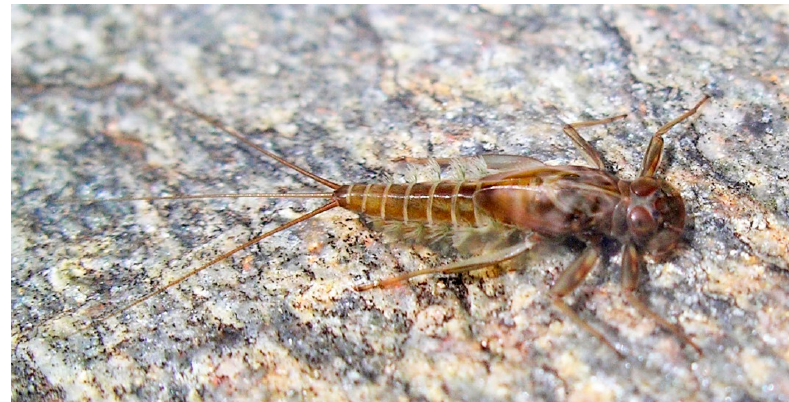
Figure 3. Rhithrogena loyolaea Navás (Heptageniidae, Switzerland) in dorsolateral view in its natural habitat; the flattened body, strong legs and first pair of gills functioning as a suction disk allow this species to withstand very strong current speed. Photograph courtesy of Laurent Vuataz.